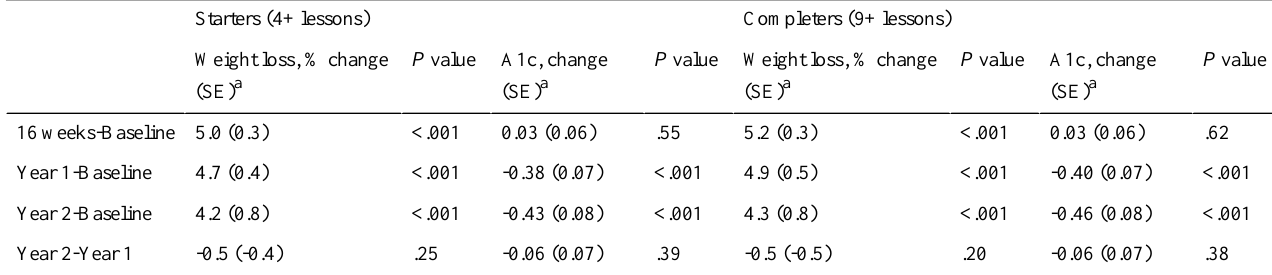
Table 3. Changes in body weight and A1c of participants over